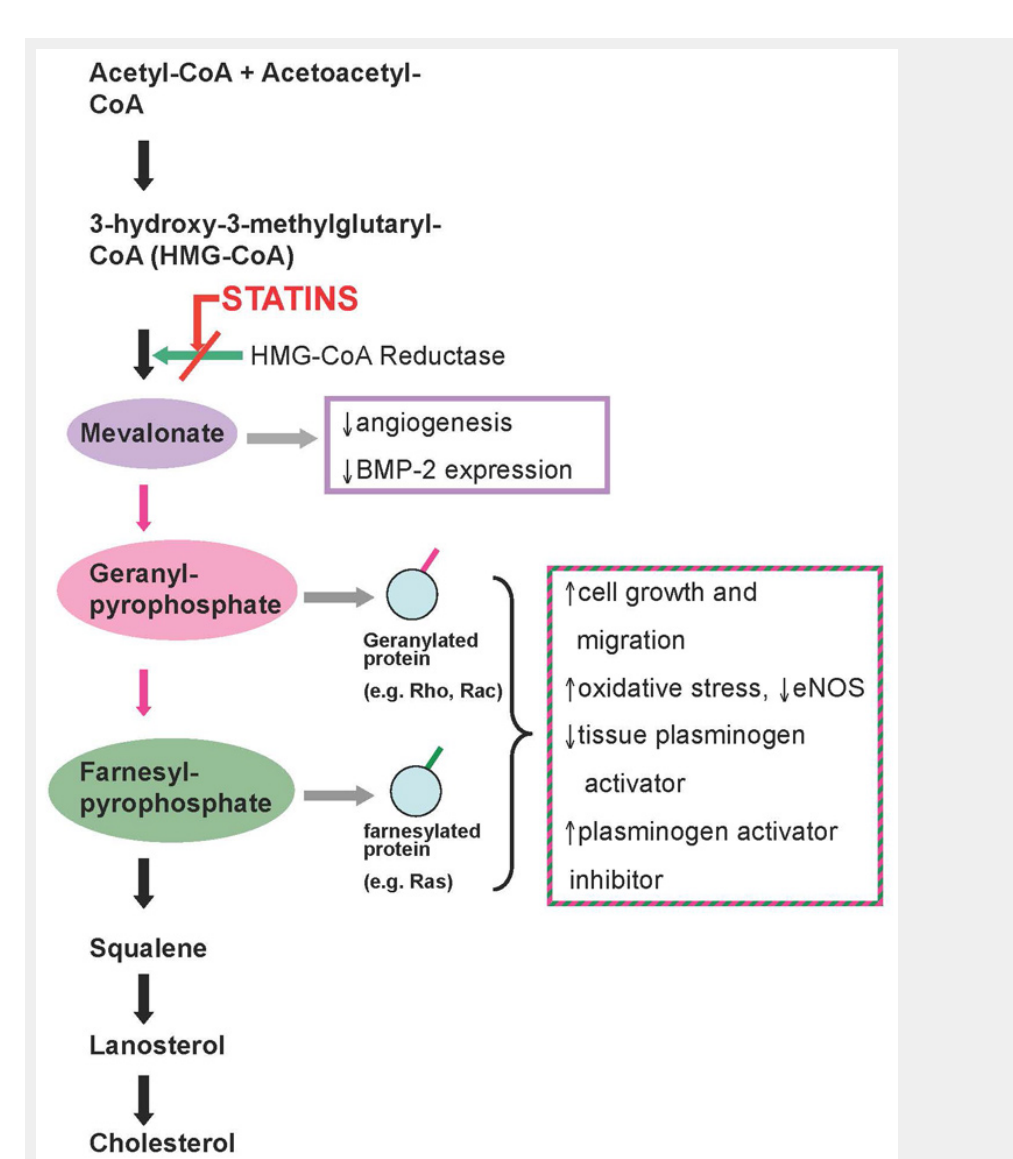
Figure 1 Essential steps of cholesterol biosynthesis . Pink arrows indicate that several intermediate molecules are not depicted. Statins inhibit the rate-limiting step of cholesterol synthesis, which is catalysed by HMG-CoA reductase. Pleiotropic statin effects are mediated by mevalonate and prenylated signaling molecules (Rho, Rac, Ras), as indicated in colored boxes. BMP-2, bone morphogenetic protein-2. e-NOS, endothelial nitric oxide synthase. Adapted, with permission, from Rutishauser J, Schweiz Med Forum. 2008;8(10):187–90,